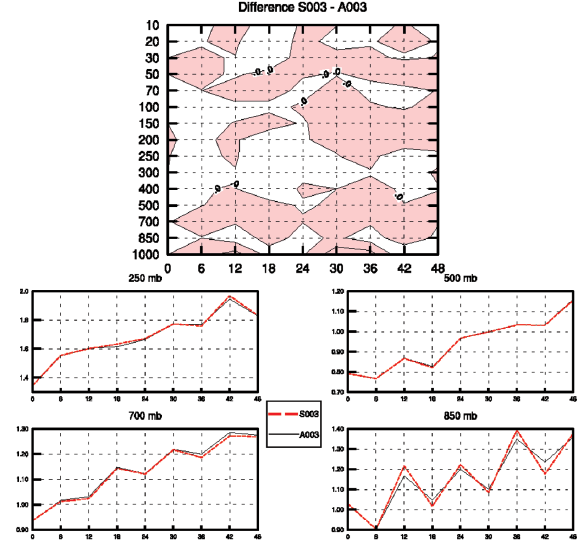
Fig. 17. Top: vertical profile of the temperature rmse difference be- tween a run with (S003) and without SURFEX (A003) as a function of forecast range averaged over a summer period (18 July 2010– 15 August 2010) and over the whole domain. Red shaded areas mean that the use of SURFEX improve the scores. Bottom: tem- perature rmse of the run with (red line) and without (black line) SURFEX at different pressure levels (250, 500, 700 and